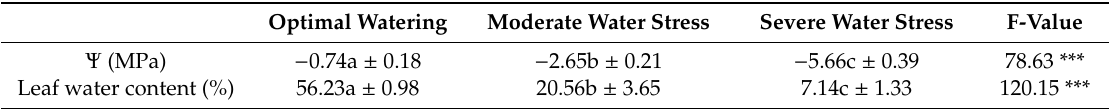
Table 1. Di ff erences among the three watering treatments in terms of stem water potential ( Ψ ) and leaf shown correspond to the mean ± standard error ( n =